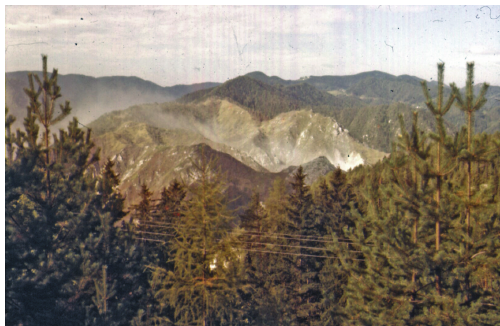
Figure 3: Upper Meˇza Valley is ranked into the 4th class of environmental pollution (dead valley). It is an area with stationary lead contamination of upper layers of soil and with very limited air self-cleansing possibilities